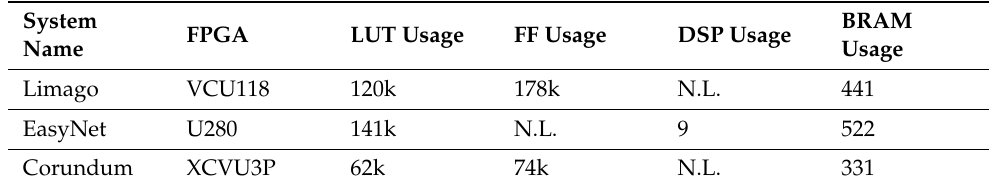
Table 1. Resource usage from Limago, EasyNet, and Corundum. N.L.: Not